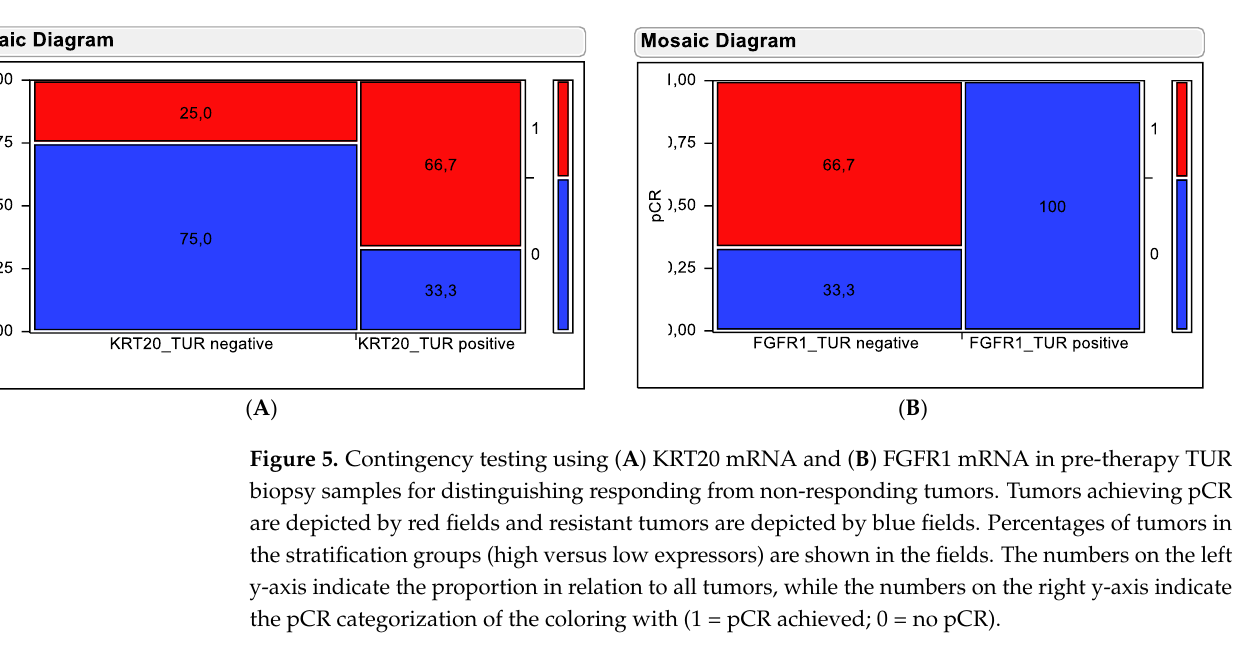
6 of 14 Figure 4. Two-dimensional hierarchy based on KRT5, KRT20, GATA3, ERBB2, FGFR3 and FGFR1 mRNA. Tumors achieving pCR are depicted by black underline and background color of sample IDs. 2.4. Contingency Testing to Evaluate Predictive Value of Marker Genes